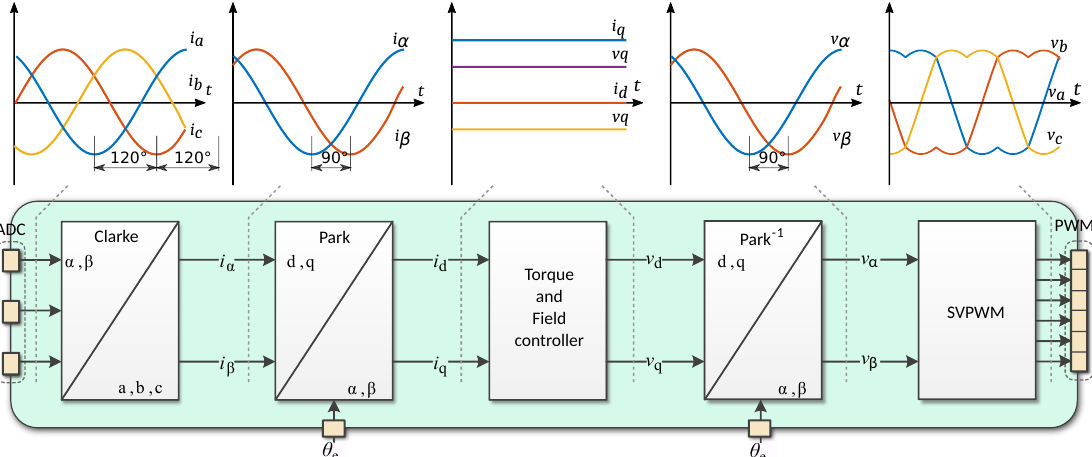
Figure A2. Illustration of the FOC commutation strategy and resulting waveforms. The turquoise box outlines the Digital Signal Processor (DSP) tasks used in